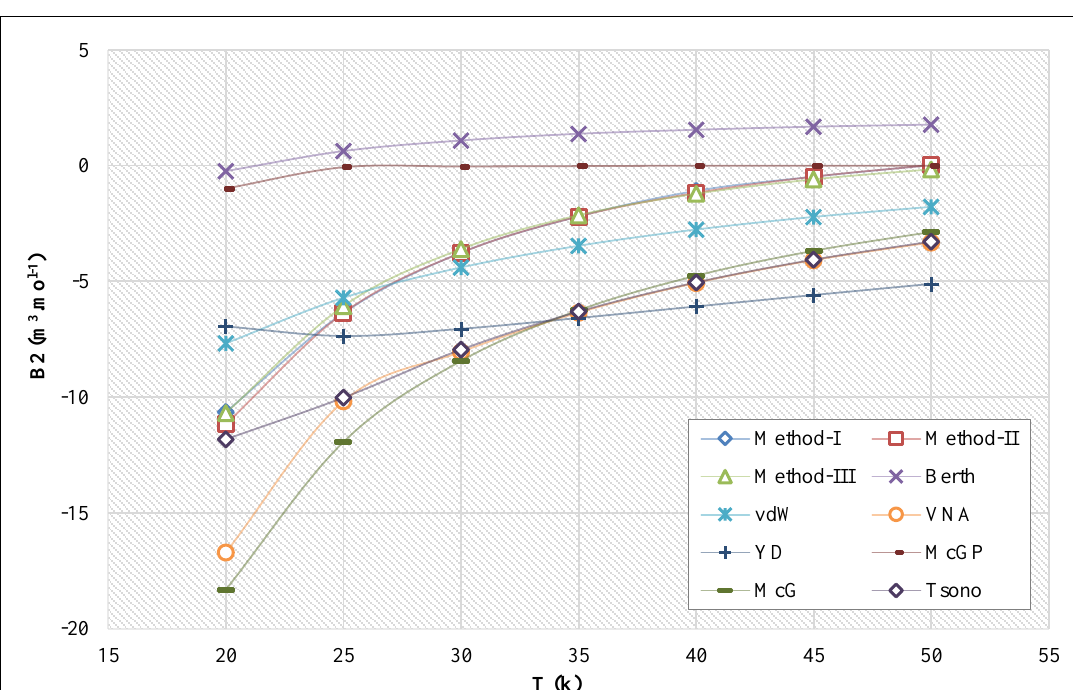
Figure 2. Second Virial Coefficient of Normal Hydrogen